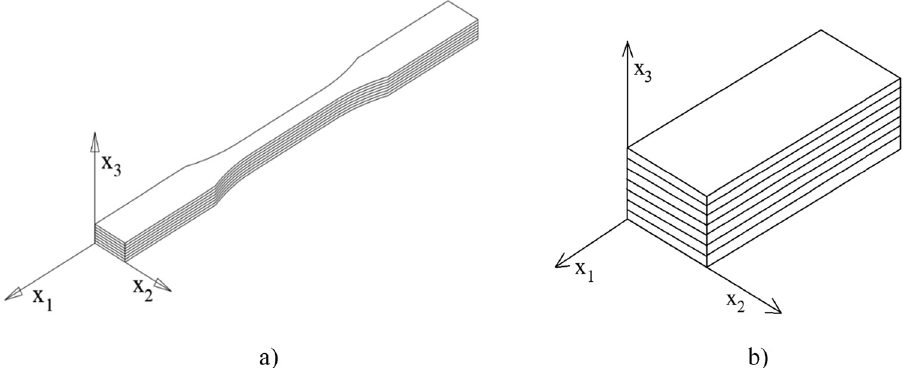
Figure 7: Orientation in the coordinate system ( a ) and the measuring part of the sample ( b )